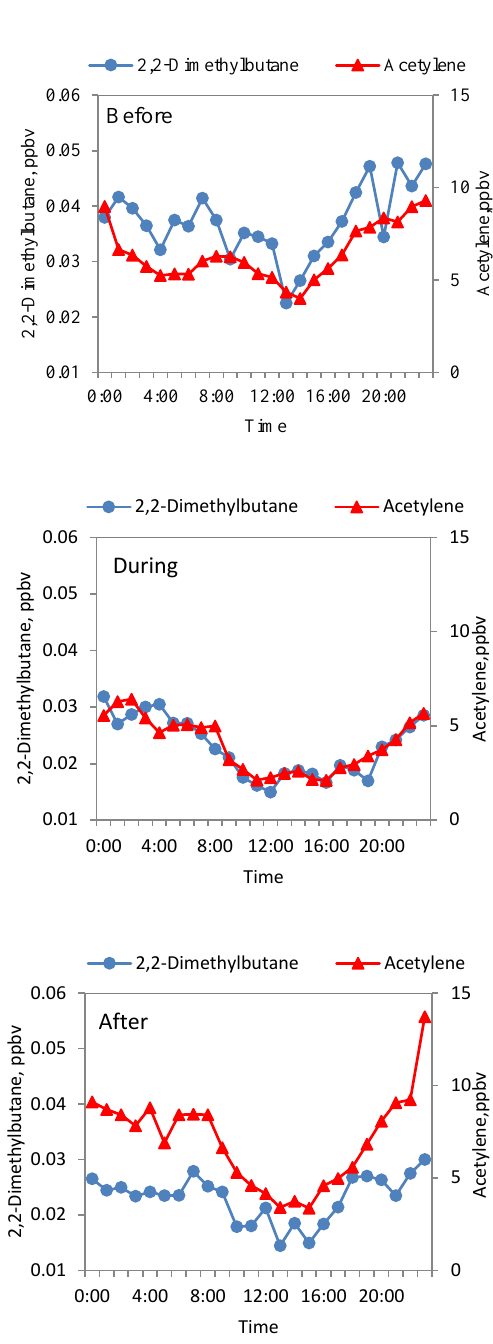
Figure 5. Diurnal variations in mixing ratios of non-methane hy- drocarbons (NMHCs) and oxygenated volatile organic compounds (OVOC) at the PKU site before, during, and after the control period during APEC China 2014.